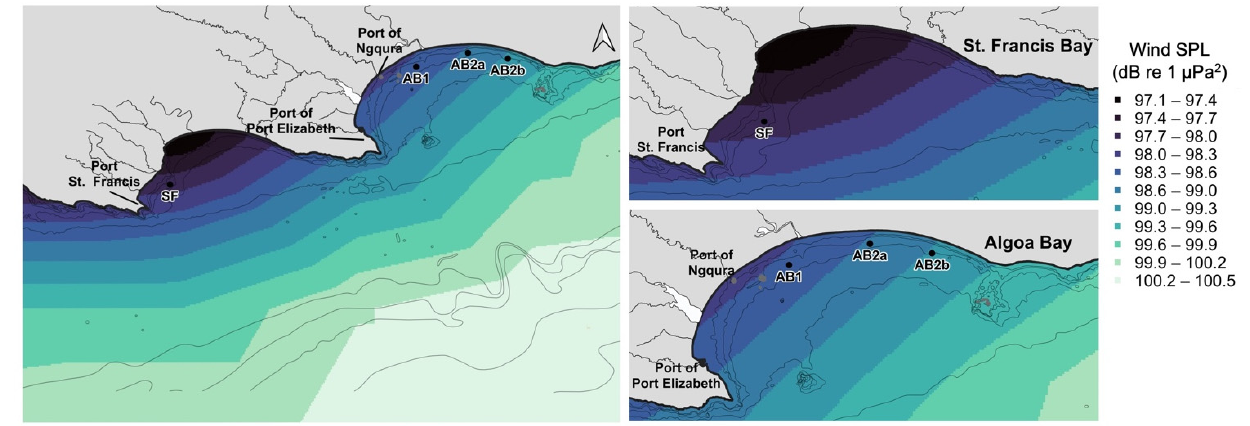
Figure 8. Modelled average wind noise levels (SPL) in St. Francis Bay and Algoa Bay over the whole of 2015. Modelled levels were similar over April–June.